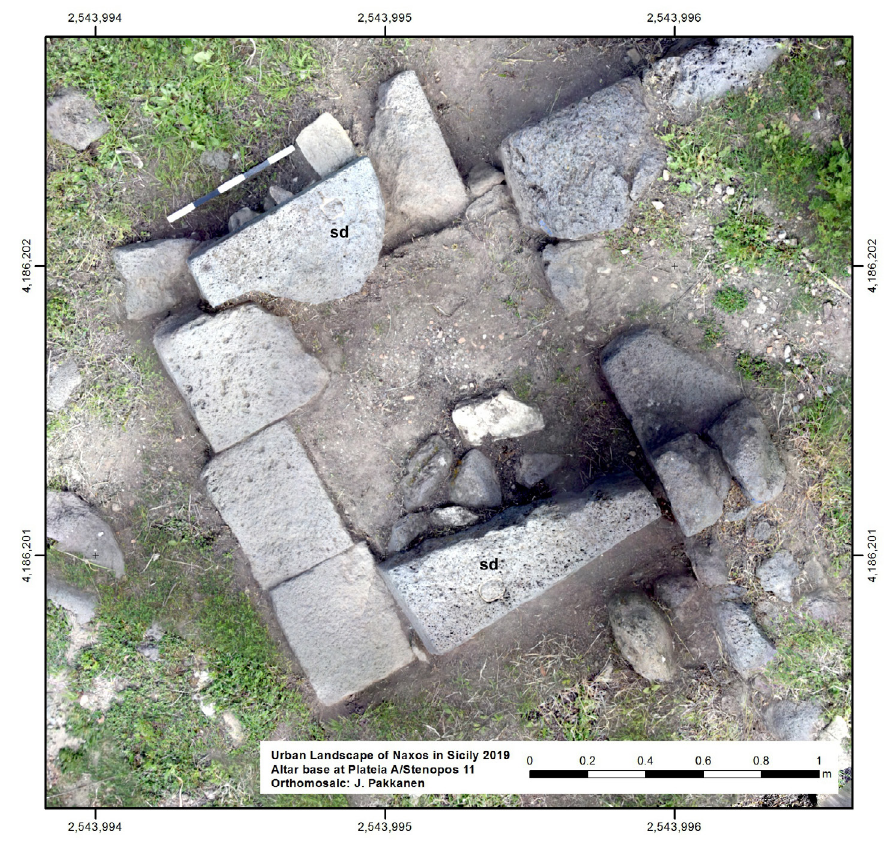
Figure 13. Orthomosaic of the rectangular altar base. Stone dowels marked with ‘sd’ (Jari